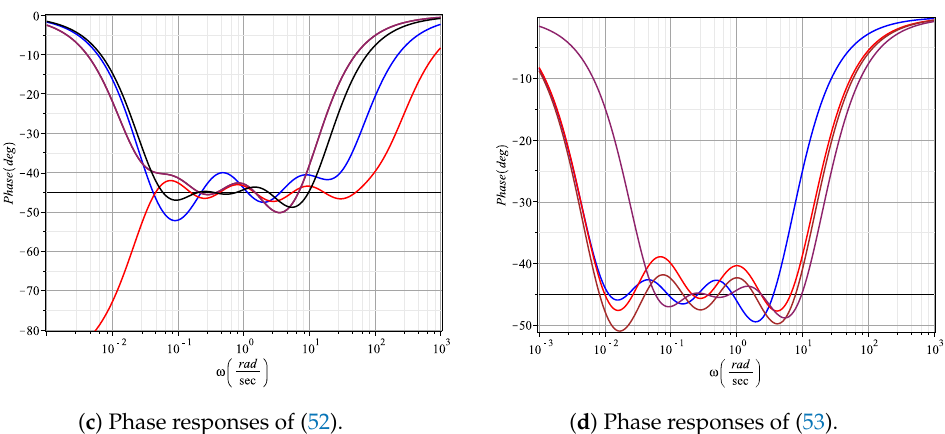
( c ) Phase responses of (52). Figure 5. Magnitude and phase diagrams of reduced order transfer functions by applying stochastic balancing method. ( a ) Ideal behavior (black line) of 1 (red line), Charef’s V1 (brown line), ideal behavior (gray line) of 1 Carlson’s (gold line), ( b ) ideal behavior (black line) of 1 expansion (red line), curve fitting (brown line) and MSBL (maroon line), ( c ) phase responses of ( a , d ), phase responses of ( b